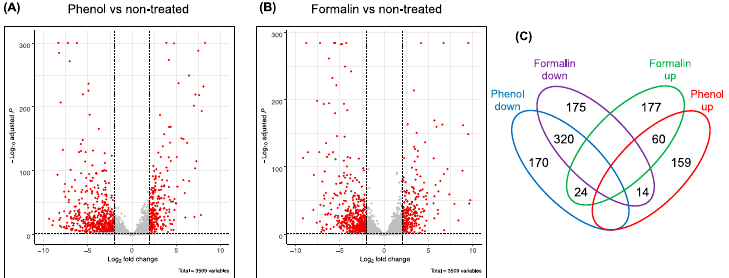
Figure 3. Analysis of RNA-seq data. ( A ) Determination of the differentially expressed genes (DEGs) from the contrast of phenol and non-treated samples (see also Table S1). Each gene analyzed can be visualized as a dot in the volcano plot. Red dots indicate genes meeting the cutoff (log2 change, 4- fold; false discovery rate < 0.01). ( B ) Comparison of DEGs from formalin and non-treated samples (Table S2). ( C ) Venn diagram indicating the number of DEGs across the comparisons to non-treated samples and the overlap between each set of genes.